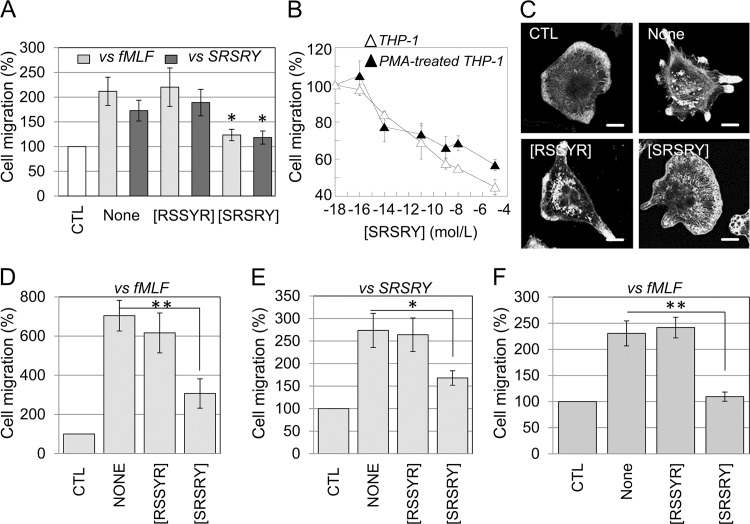
[SRSRY] inhibits migration of monocytes and macrophages in a dose-dependent manner causing a marked inhibition of fMLF-dependent cytoskeletal re-organization.A. THP-1 cells (1x105 cells/well) were allowed to migrate for 90 minutes at 37°C, 5% CO2 in Boyden chambers toward 10 nM fMLF, or 10 nM SRSRY in the presence of diluents (None), 10 nM [RSSYR] or 10 nM [SRSRY]. The arbitrary value of 100% was given to the basal cell migration, assessed in the absence of chemoattractant (CTL) and the results were expressed as percentage of the basal cell migration. Data are expressed as the means ± SD of three independent experiments, performed in duplicate. *Statistical significance against None with p<0.001. B. THP-1 and PMA-stimulated THP-1 cell migration toward 10 nM fMLF plus increasing concentrations of [SRSRY] in Boyden chambers. The extent of cell migration was expressed as a percentage of the net fMLF-dependent cell migration, considered as 100%. Data are expressed as the means ± SD of three independent experiments, performed in duplicate. C. Representative images of PMA-stimulated THP-1 cells allowed to migrate in a DUNN chamber toward diluents (CTL), or a fMLF chemotactic gradient, in the absence (None) or presence of 10 nM [SRSRY] or [RSSYR] peptides and stained with rhodamine-phalloidin. Scale bar: 10 μm. Original magnifications: 630x. D-E. Primary monocytes (1x105 cells/well) were allowed to migrate for 90 minutes at 37°C, 5% CO2 in Boyden chambers toward 10 nM fMLF (D), or 10 nM SRSRY (E) in the presence of diluents (None), 10 nM [RSSYR] or 10 nM [SRSRY]. The arbitrary value of 100% was given to the basal cell migration, assessed in the absence of chemoattractant (CTL) and the results were expressed as percentage of the basal cell migration. Data are expressed as the means ± SD of three independent experiments, performed in duplicate. *Statistical significance against None with p<0.001; **Statistical significance against None with p<0.0001. F. Primary macrophages allowed to migrate in a DUNN chambers toward diluents (CTL), or a 10 nM fMLF gradient, in the absence (None) or presence of 10 nM [SRSRY] or 10 nM [RSSYR] peptides. For quantitative analysis, a total of 100 macrophages/sample that translocated to the area corresponding to the outer well were counted with an inverted microscope. The arbitrary value of 100% was given to the basal cell migration, assessed in the absence of chemoattractant (CTL) and the results were expressed as percentage of the basal cell migration. *Statistical significance with p<0.001. **Statistical significance with p<0.0001.